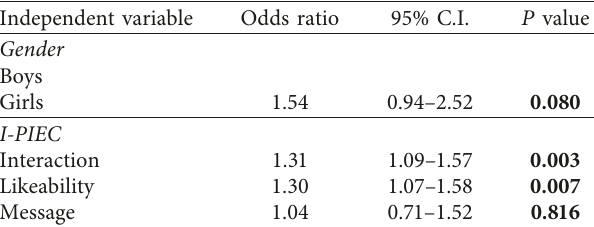
Table 6: Logistic regression analysis of factors associated with disordered eating attitudes and behaviors independent ( n � 738).